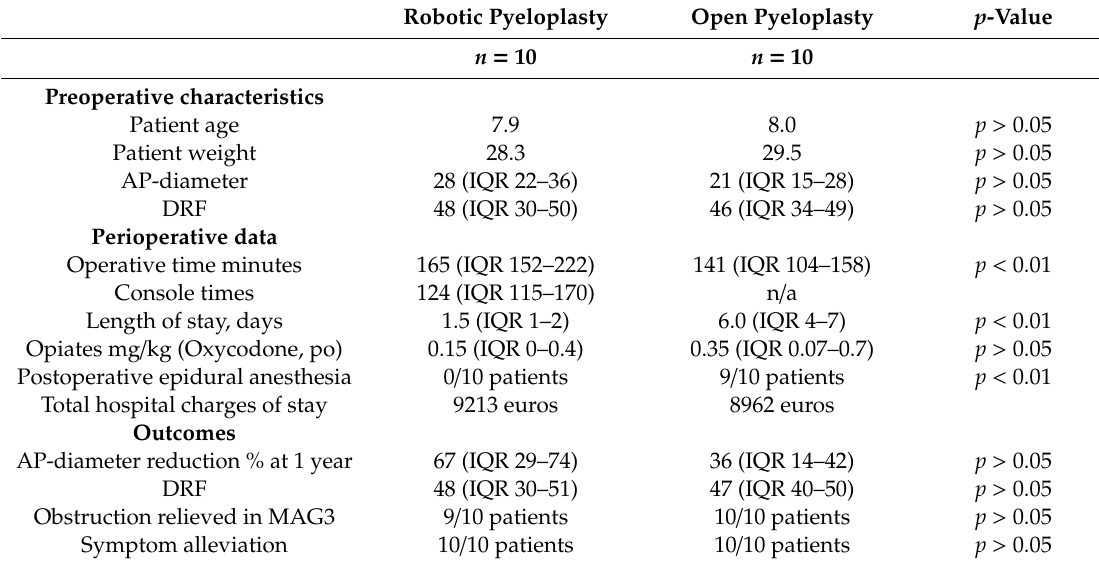
Table 1. Comparison of preoperative data, perioperative data and